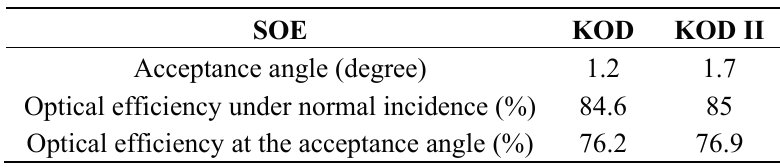
Table 3. Comparison of the optical performance of the Fresnel lens with kaleidoscope with equal optical path design (KOD) SOE and KOD II SOE.